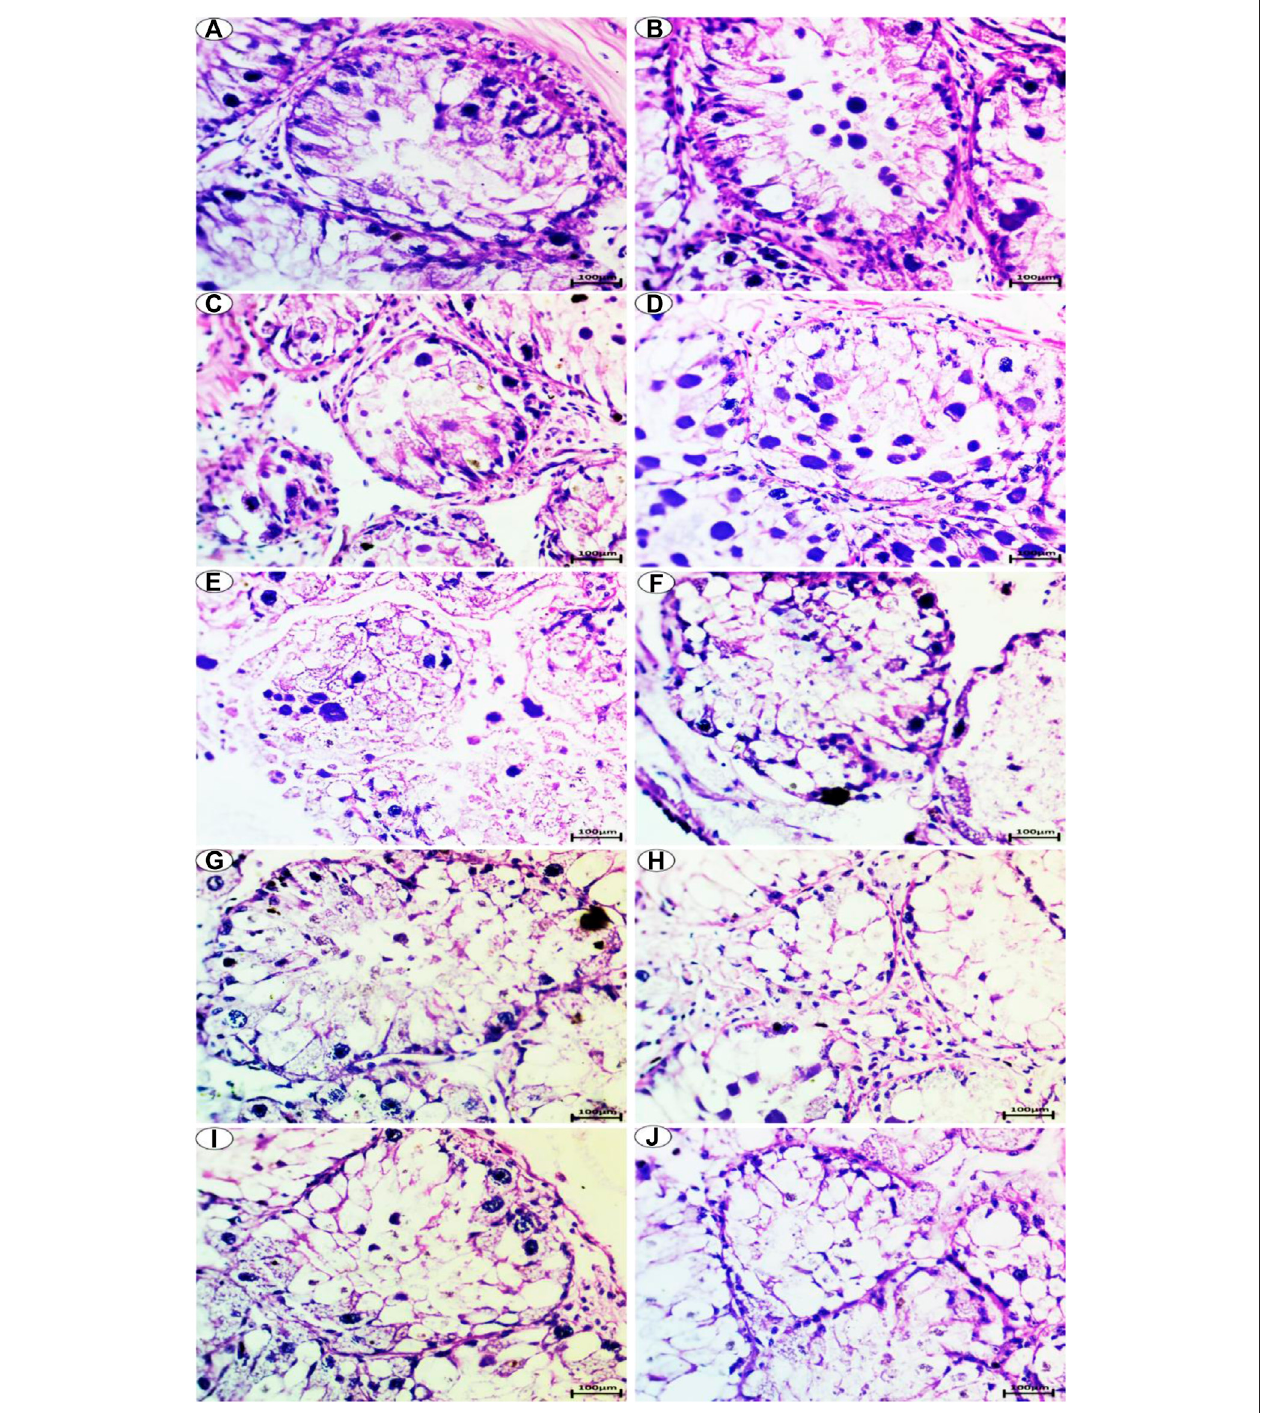
FIGURE4| Photomicrograph ofdigestive gland ofSlug Lehmannianyctelia after the exposure to (A,B) Control group, (C) ;0.04 g/LofAgNPs, (D) ;0.08 g/LofAg NPs, (E) ; 0.4 g/Lof Ag NPsand (F) ; 0.8 g/L of AgNPs, (G) ; 0.04 g/L of silver nitrate, (H) ; 0.08 g/L ofsilver nitrate, (I) ; 0.4 g/L of silver nitrate, (J) ; 0.8 g/L ofsilver nitrate. (PAS and hematoxylin, scale bar 100 μ